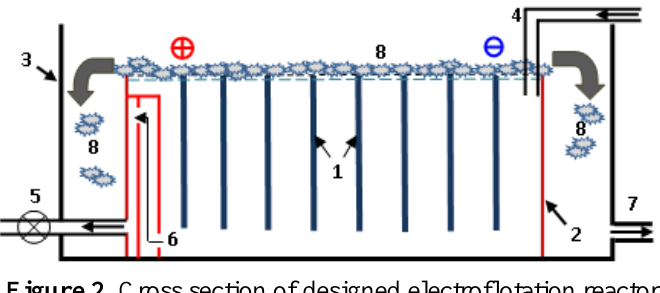
Figure 2. Cross section of designed electroflotation reactor.